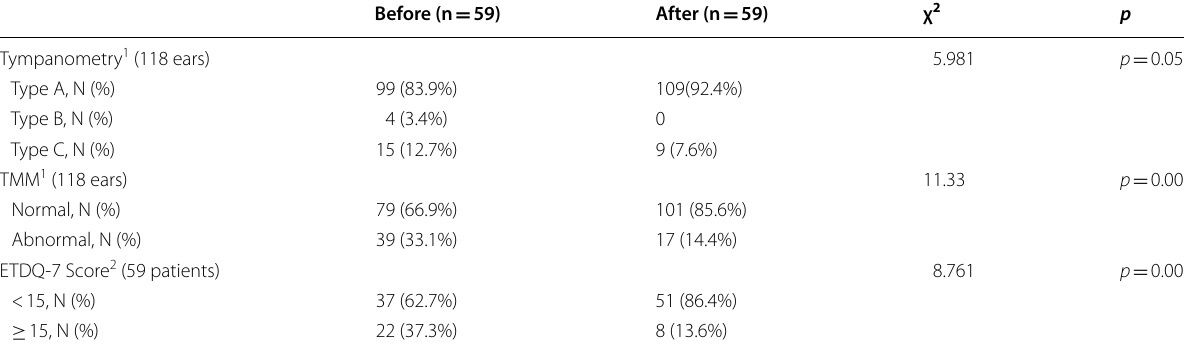
1 Statistical analysis was performed by the number of ears 2 Statistical analysis was performed by the number of patients TMM tubomanometry, ETDQ-7 seven-item Eustachian Tube Dysfunction